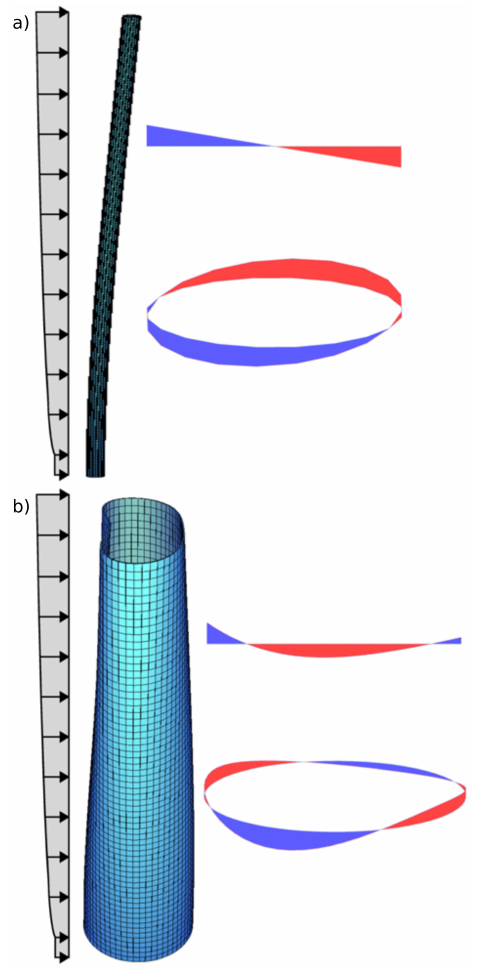
Figure 3. Meridional internal forces at the bottom for slim (a) and wide (b) cylindrical shells exposed to wind